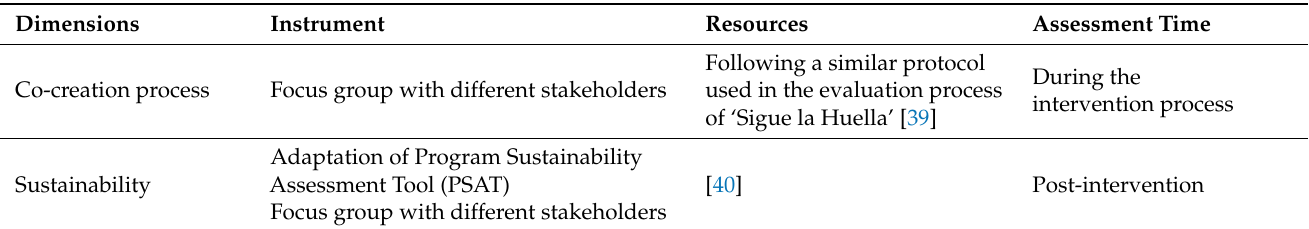
Table 3. Dimensions and instruments to evaluate the dissemination and implementation